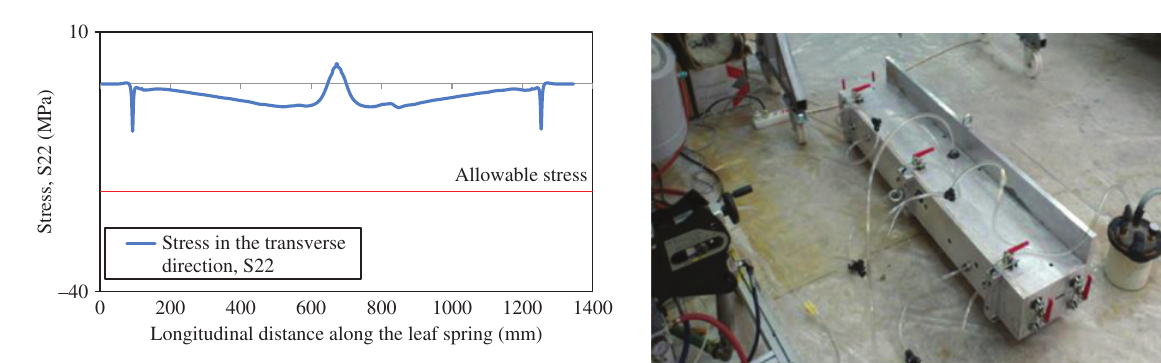
Figure 11: S22 stress distribution on the glass and carbon fiber/ epoxy leaf spring bottom surface along the longitudinal length. Figure 12: Manufacturing setup for the composite-based mono-leaf